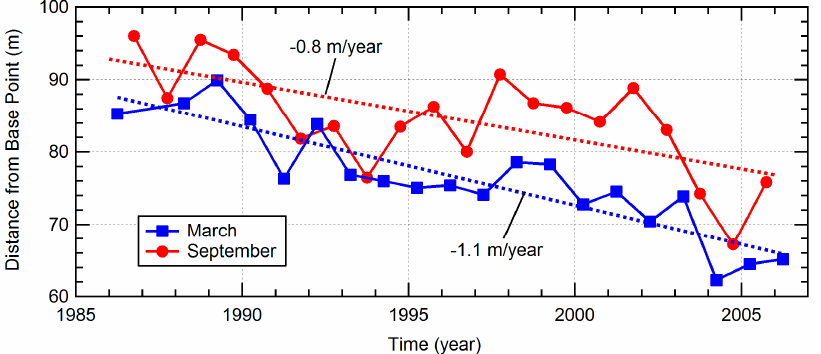
Figure 5. Long ‐ term trend of shoreline change. Figure 5. Long-term trend of shoreline change.